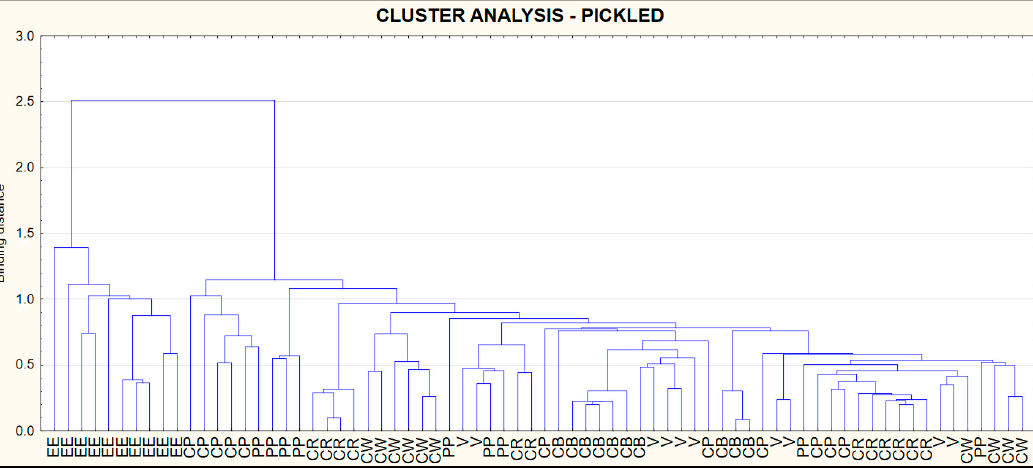
Figure 8. Dendrogram of similarity in protein, fat, salt, collagen and water in pickled fish.